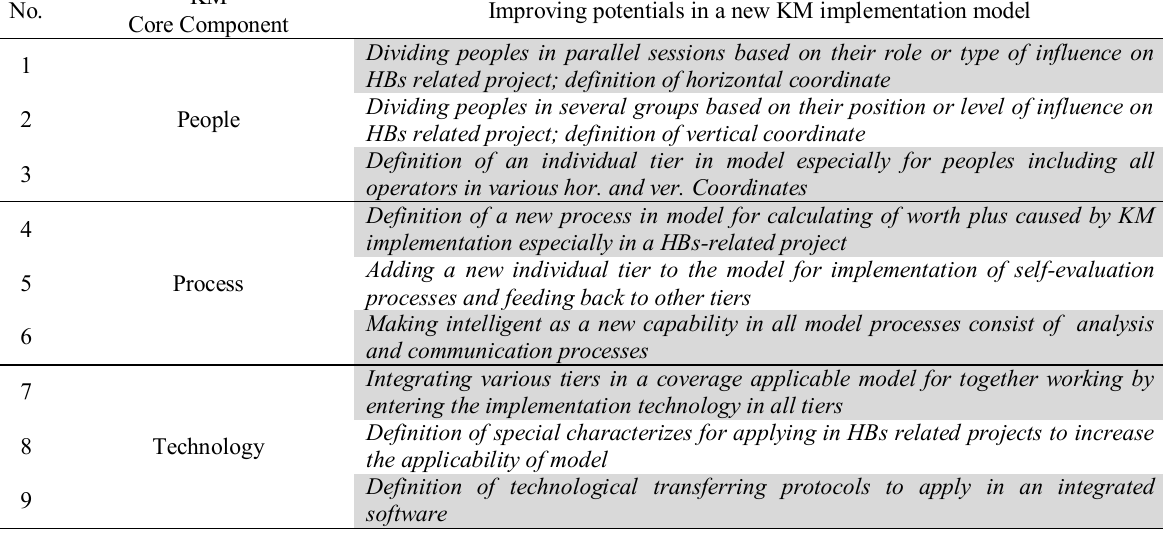
Main improving potentials to be considered in a new applicable KM implementation model for HBs- related